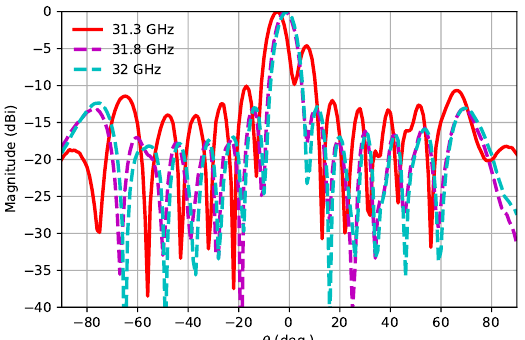
Figure 19. Measured E-plane radiation patterns ( E θ ) for different frequencies.